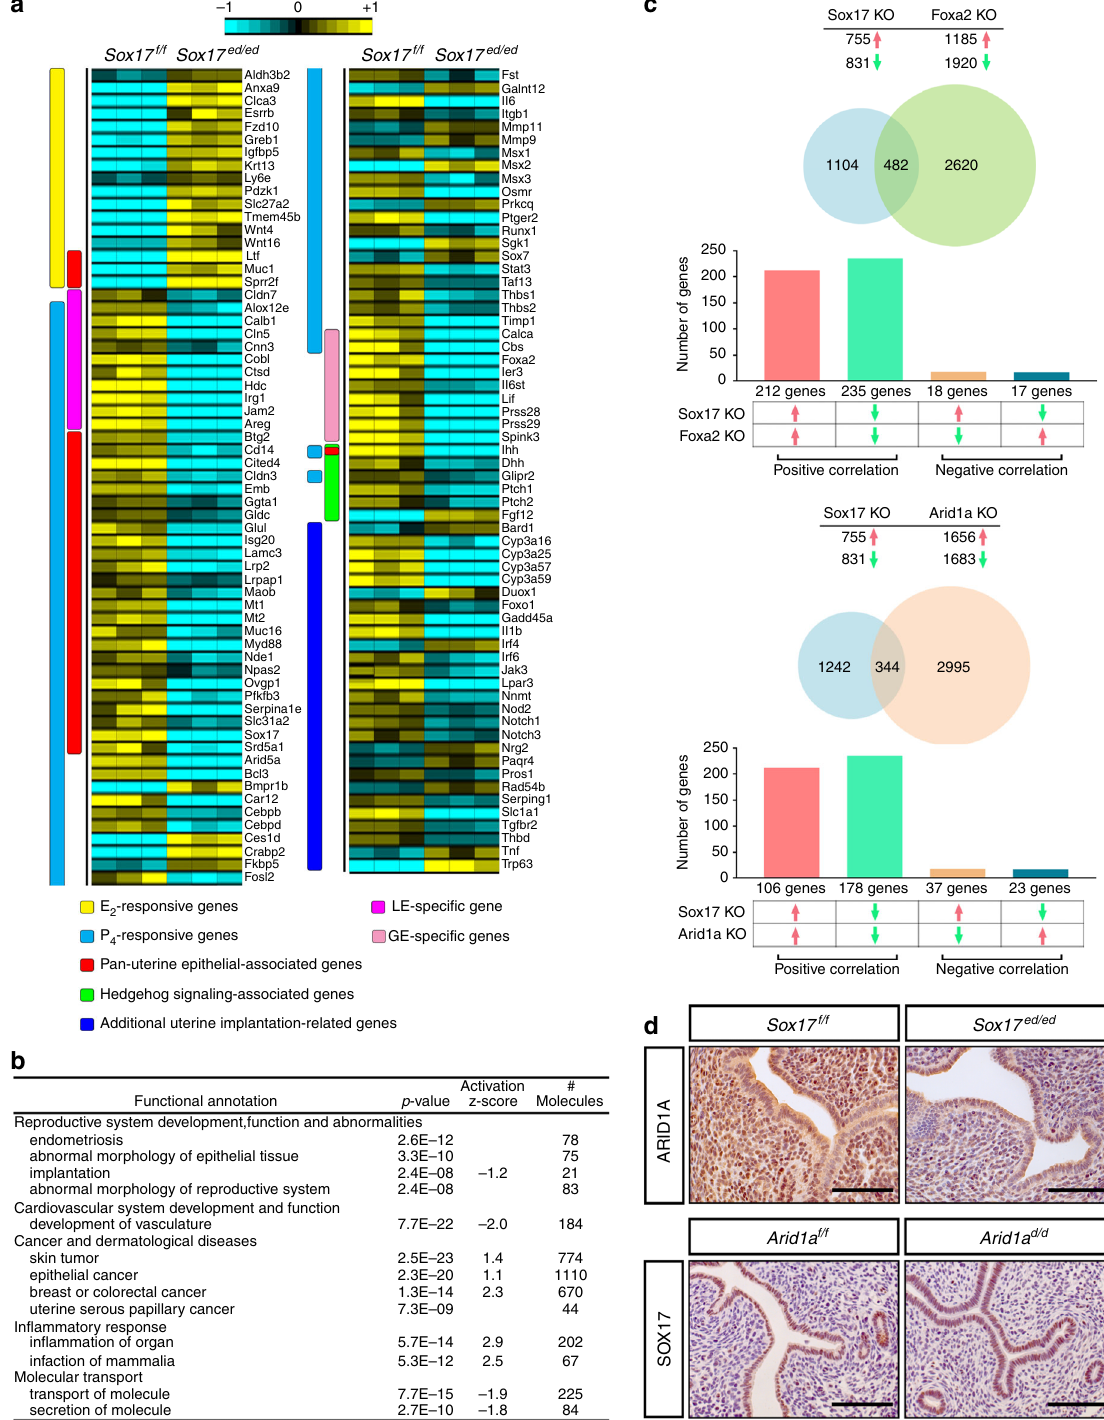
Fig. 4 SOX17 regulation of uterine transcriptome. a Heatmap of uterine function-associated genes differentially regulated between Sox17 f/f and Sox17 ed/ed mouse uteri at GD 3.5 generated from microarray analysis. b Enrichment of functional annotation in differentially expressed genes between Sox17 f/f and Sox17 ed/ed mouse uteri at GD 3.5 by IPA analysis. c Overlaps and correlations of Sox17 KO with Foxa2 KO or Arid1a KO transcriptomes generated by NextBio gene expression pro fi le comparison. d Immunohistochemical staining of ARID1A in GD 3.5 uteri from Sox17 f/f and Sox17 ed/ed mice ( n = 3; row 1), as well as SOX17 in GD 3.5 uteri from Arid1a f/f and Arid1a d/d ( Pgr Cre Arid1a f/f ) mice ( n = 3; row 2) Scale bars: 100 µ